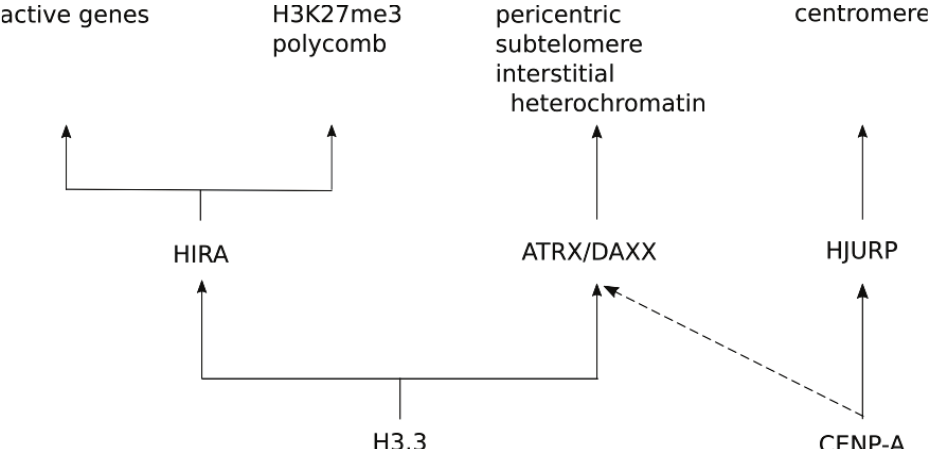
Figure 3. Competition between H3.3 and CENP-A for chaperone complex